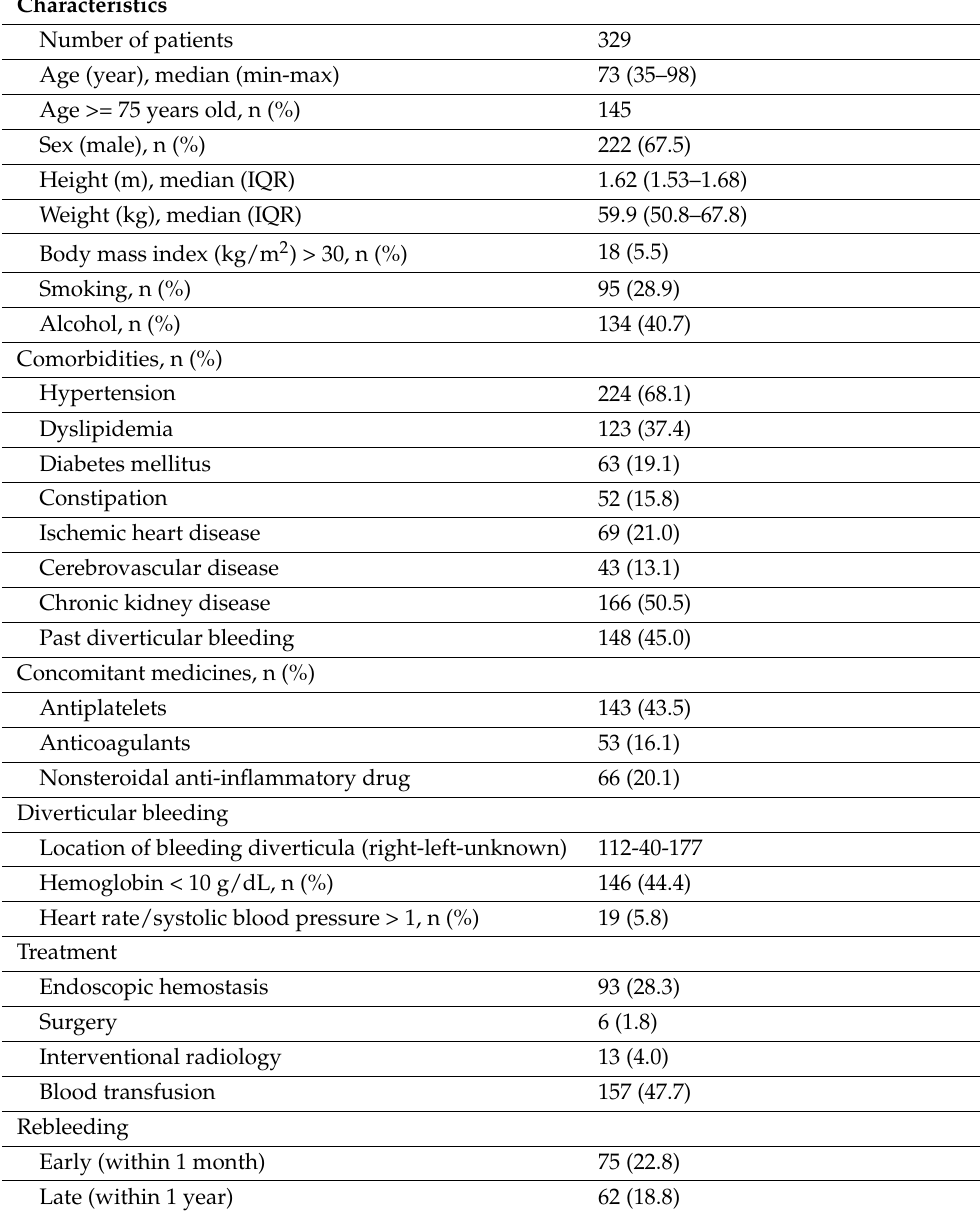
Table 1. Background characteristics of the